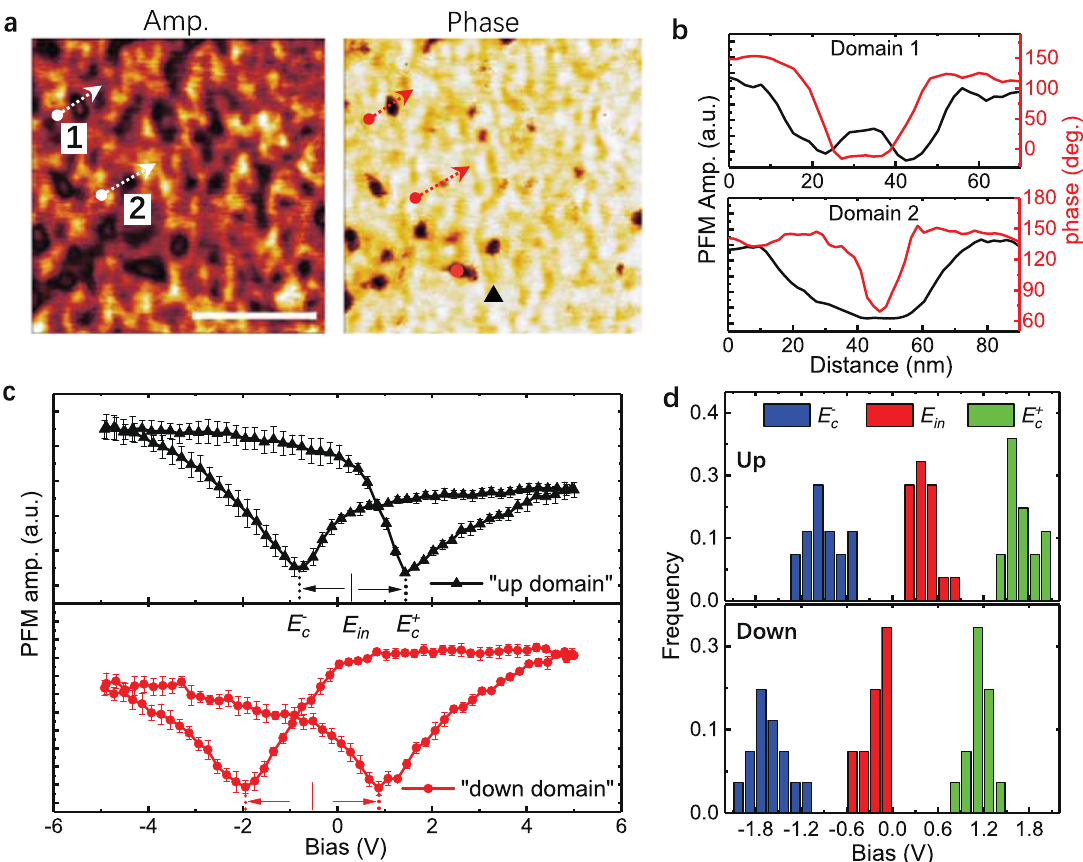
Fig. 2 Analysis of the nanodomains in 5-BTO by PFM. a Zoomed-in piezoelectric force microscopy (PFM) image of the nanodomains in the aged 5-BTO fi lm with a scale bar of 200 nm. b Cross-section line pro fi les of the phase and amplitude of the down domains indicated by arrows in ( a ). From the amplitude pro fi le, domain wall can be distinguished from the domain interior for Domain 1 (~20 nm), but impossible for Domain 2 with a smaller size (<10 nm). c Representative PFM hysteresis loops of up and down domains. While the up domain exhibits a loop shifting to the positive fi eld side, the loop of the down domain shifts to the negative side. The hysteresis loops were an average of ten loops acquired from the same location, with the error bar representing a standard deviation. d Statistic of the extracted E c + , E c – , and E in for 30 different up and down domains,